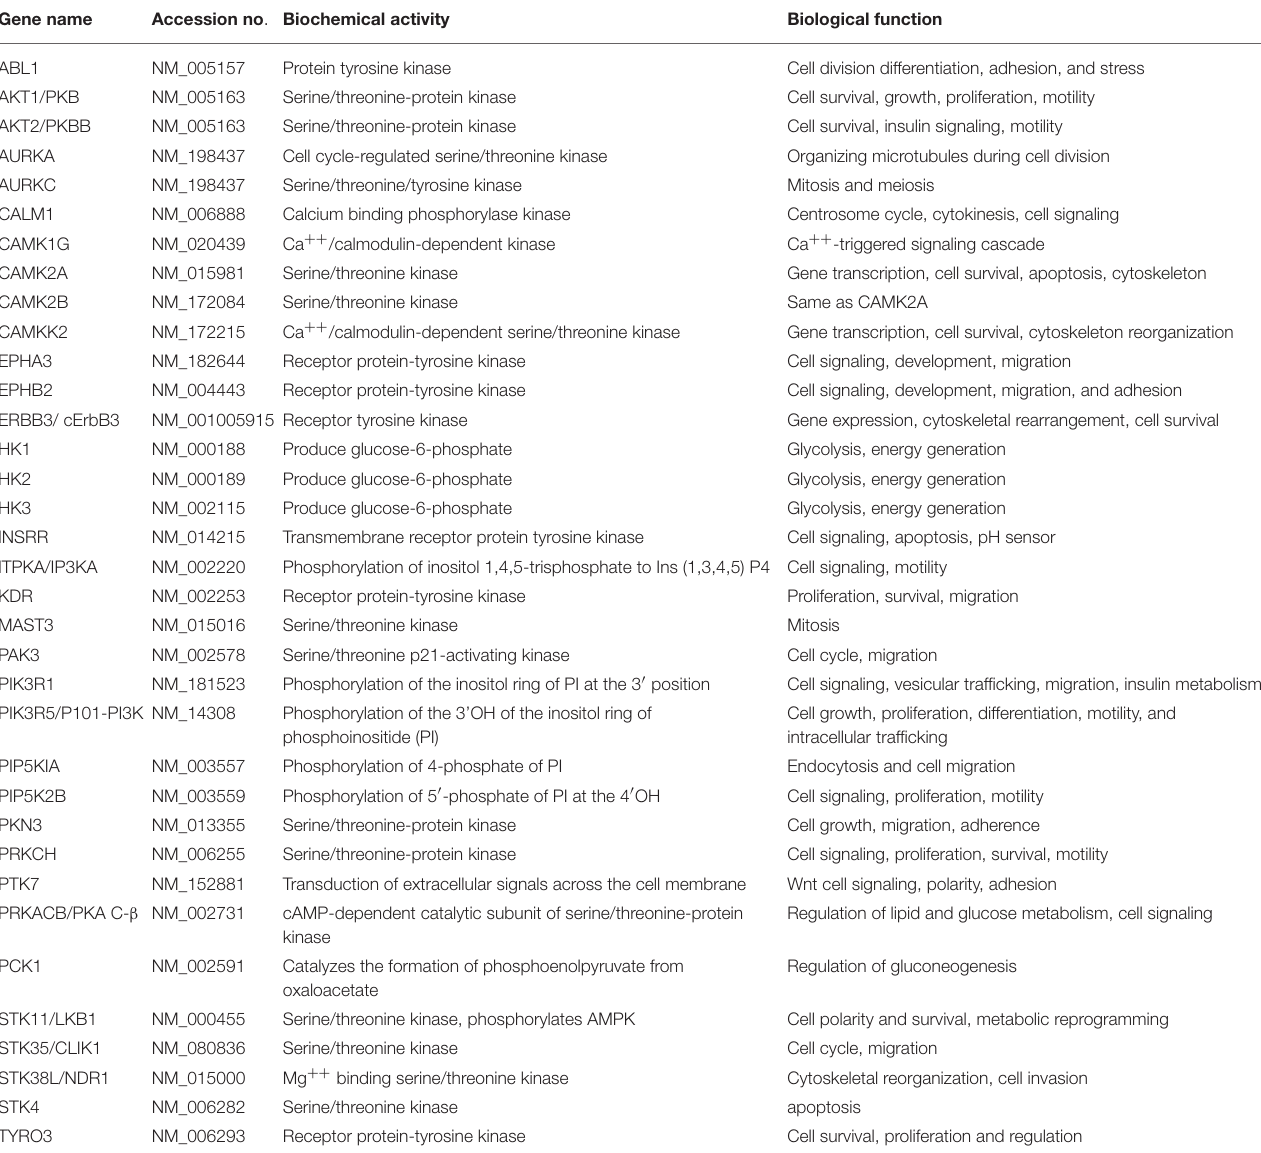
TABLE 1 | Host genes required for intracellular B. thailandensis